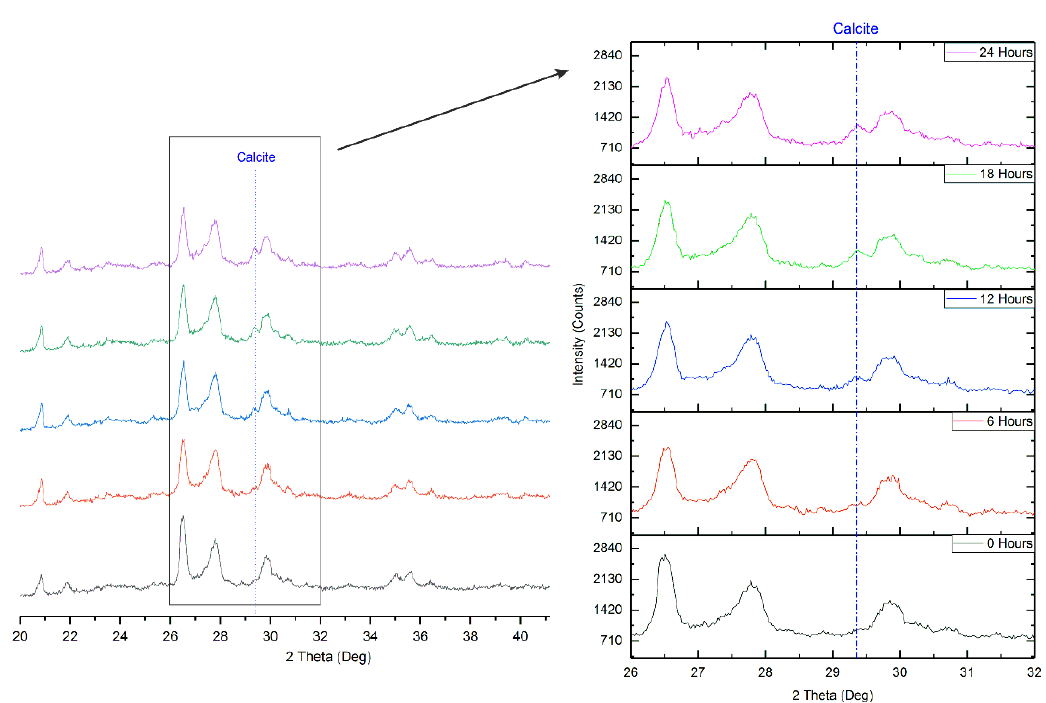
Figure 3. In situ XRD MPC2 pattern where d = 3.04 Å, reflection corresponding to precipitated newly formed calcite.